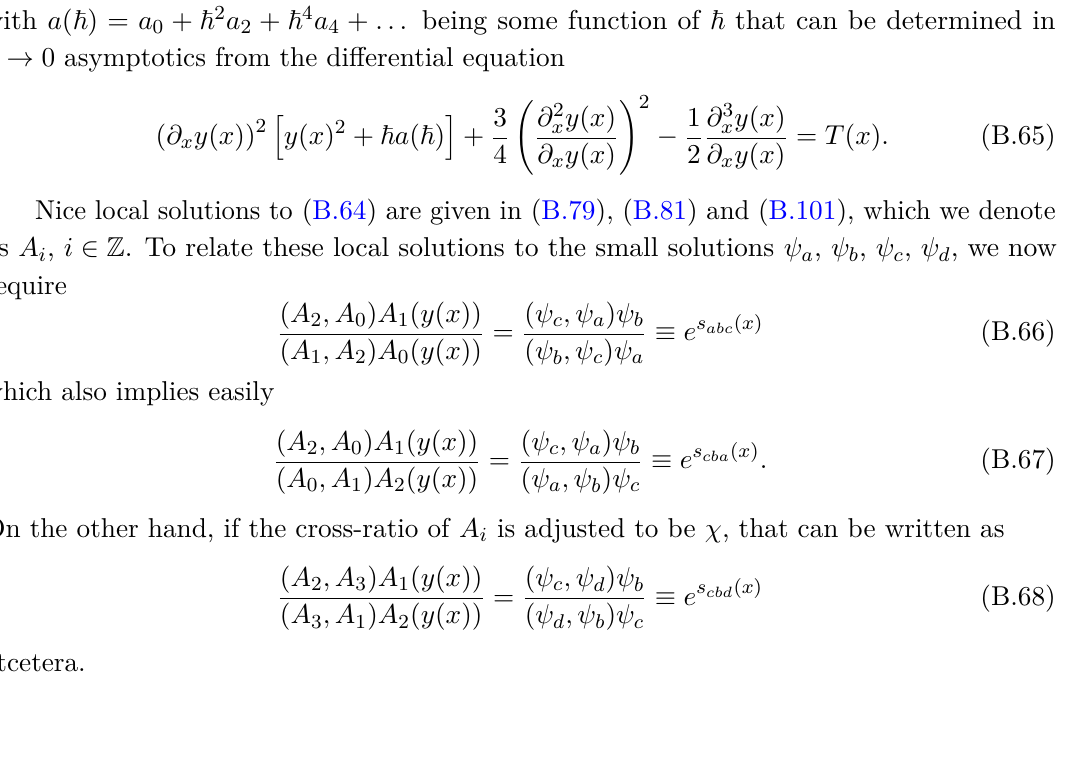
Figure 4 . The Stokes diagrams in the local coordinate system around the simple zero and the double zero. The numbers close to the origin label the numbering for the nice local solutions A we use in this section, whereas ψ label the corresponding small •